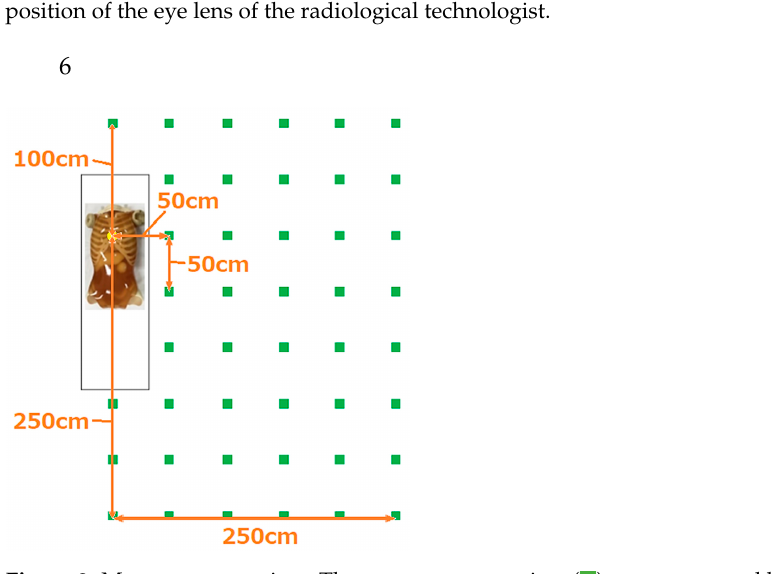
Figure 2. Measurement points. The measurement points ( ■ ) were separated by a distance of 50 cm. We measured the scattered dose during mobile radiography according to the bed and measurement